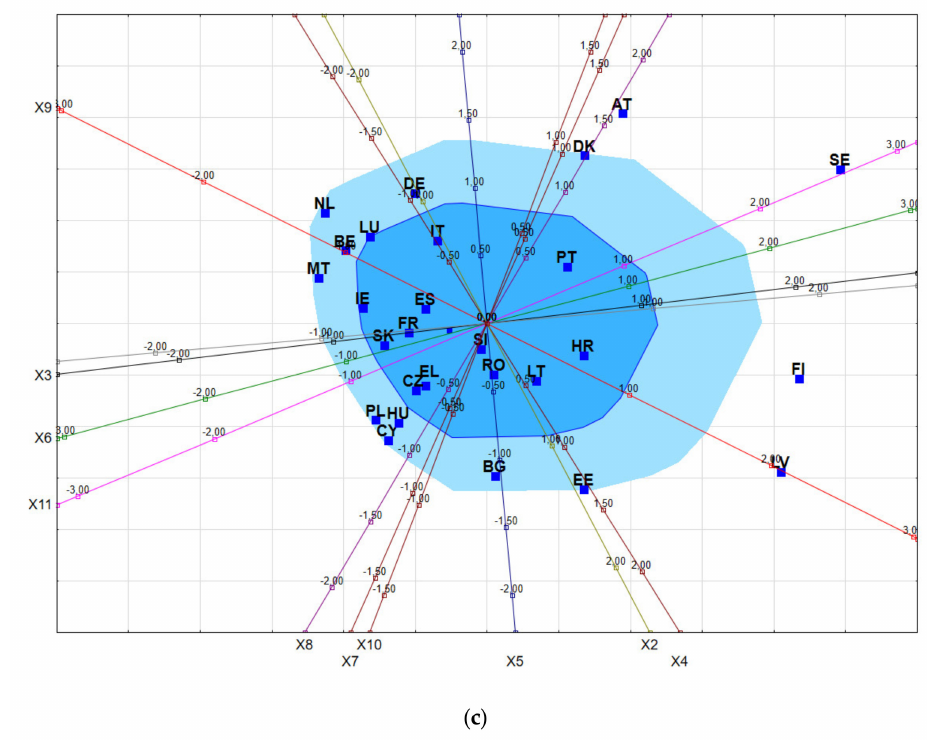
Figure 5. Location of the EU-27 Member States in 2008 ( a ), 2013 ( b ), and 2018 ( c ). Table 10. Distance of studied countries from the pattern and anti-pattern together with the TOPSIS measure for the level of renewable energy and biofuels in 2008, 2013, and